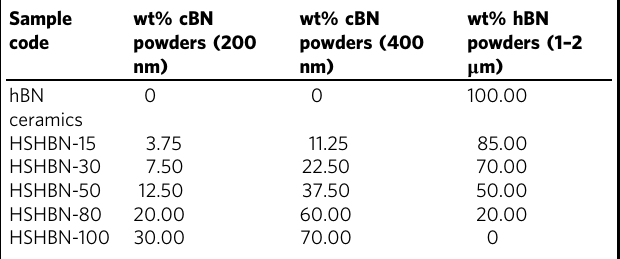
Table 2 A list of the examined compositions Sample code